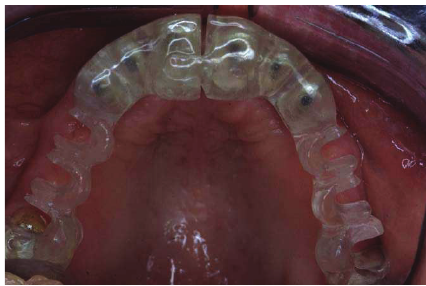
Figure 19: The osteotomy was completed following the surgical stent.